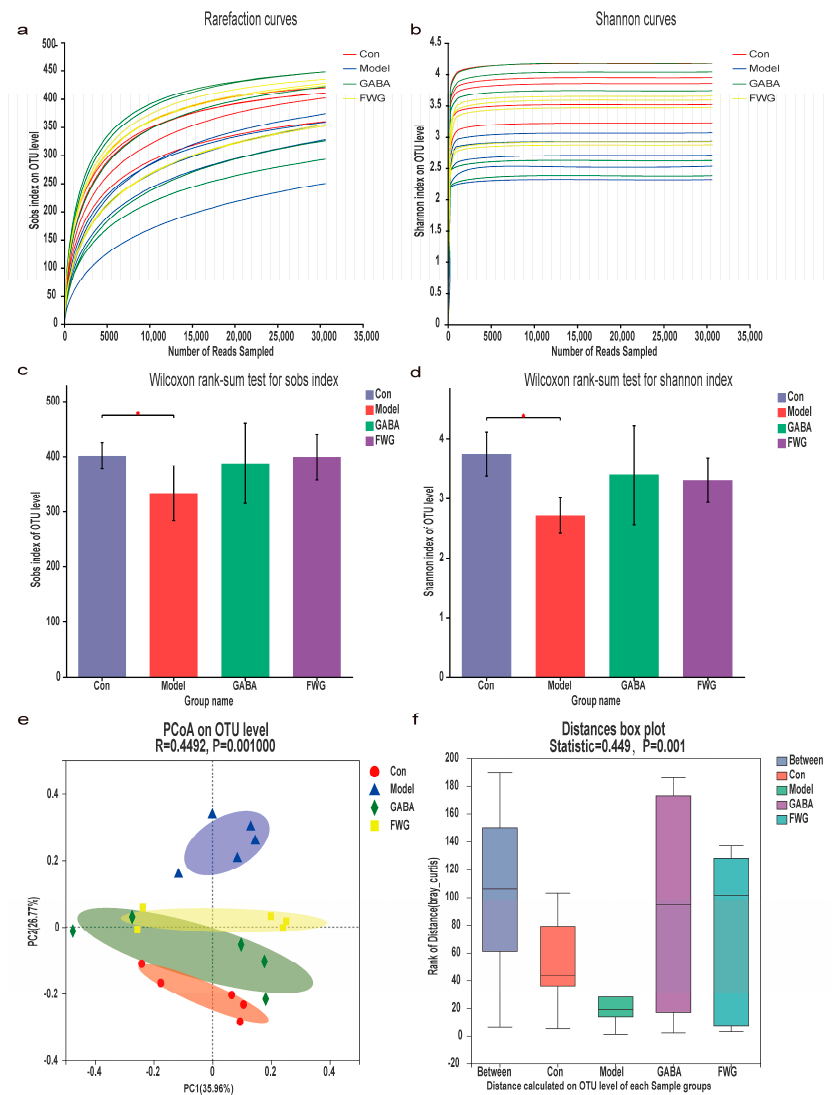
Figure 4. Analysis of gut microbe diversity. ( a ) Sample dilution curve based on Sobs index. ( b ) Sample dilution curve based on Shannon index. ( c ) Wilcoxon rank–sum test for Sobs index of differences between index groups. ( d ) Wilcoxon rank–sum test for Shannon index of differences between index groups. ( e ) PCoA analysis based on beta diversity analysis. ( f ) The results of an analysis of similarity (ANOSIM) based on PCoA. (* p < 0.05 indicates a statistically significant difference.)